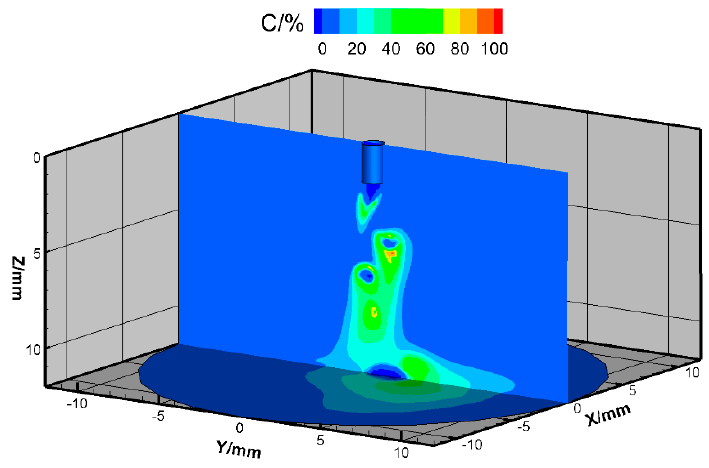
Figure 5. Metal vapor distribution for high-current GMAW.